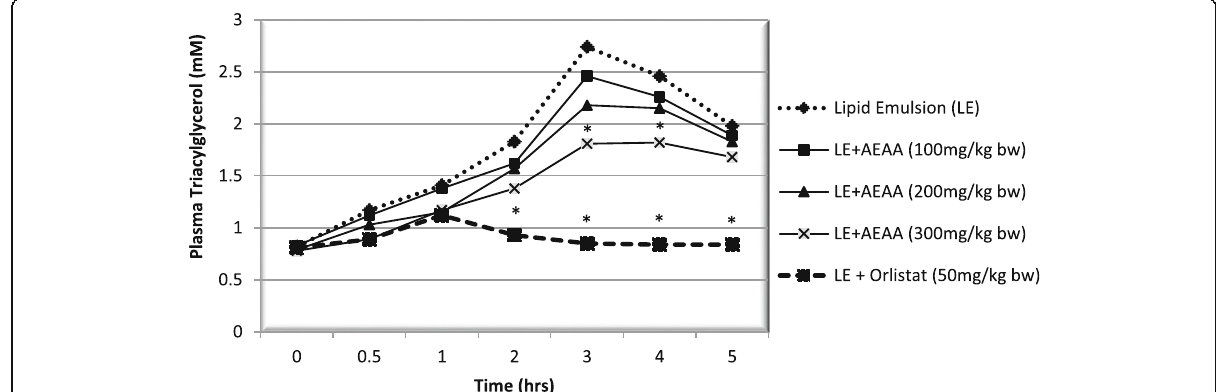
Fig. 3 Plasma triacylglycerol levels after oral administration of lipid emulsions to rats; values are mean of 6 rats; * p < 0.05, significantly different from lipid emulsion only treated group; LE – Lipid Emulsion; AEAA – Aqueous Extract of Achyranthes aspera L.